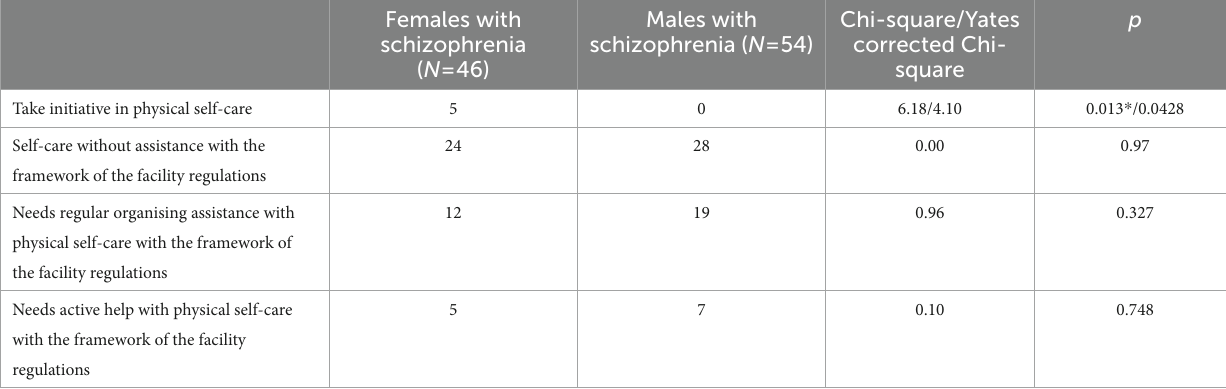
Males with schizophrenia ( N = 54)